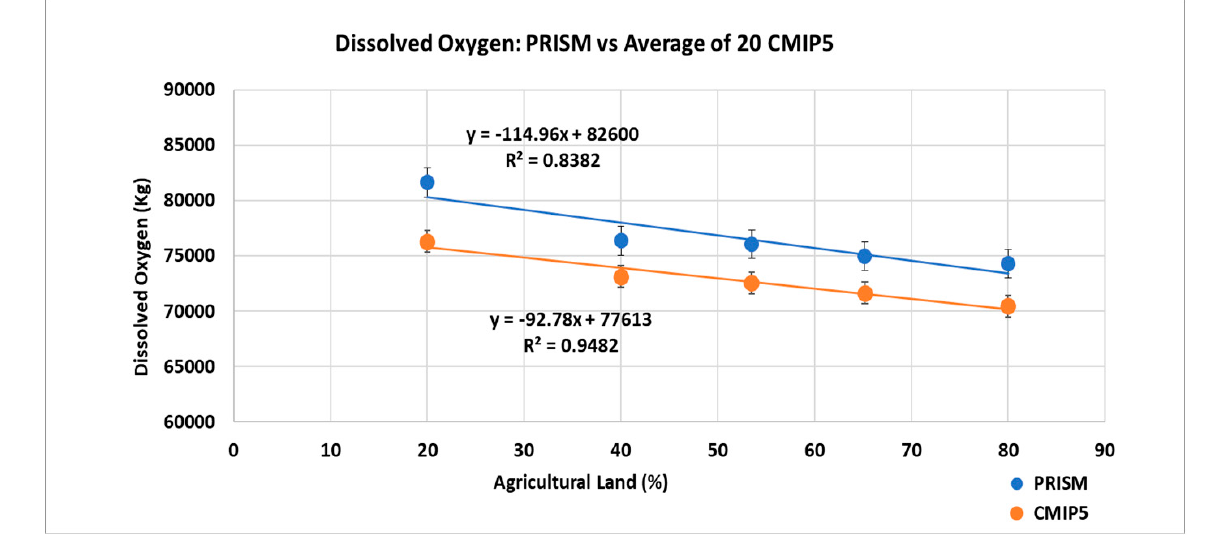
Figure 10. PRISM vs. 20 CMIP5 GCMs for dissolved oxygen.